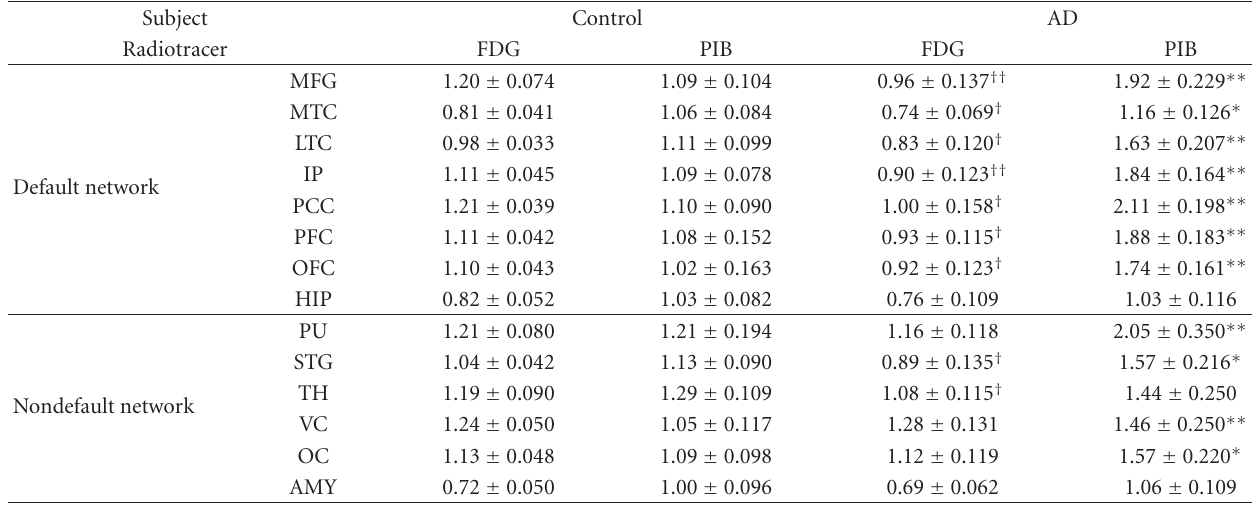
Table 2: 2-[ 18 F]fluoro-2-deoxy- D -glucose (FDG) and [ 11 C]-labeled Pittsburgh Compound B (PIB) uptakes in the default network regions and regions outside the default network in Alzheimer’s disease (AD) and control